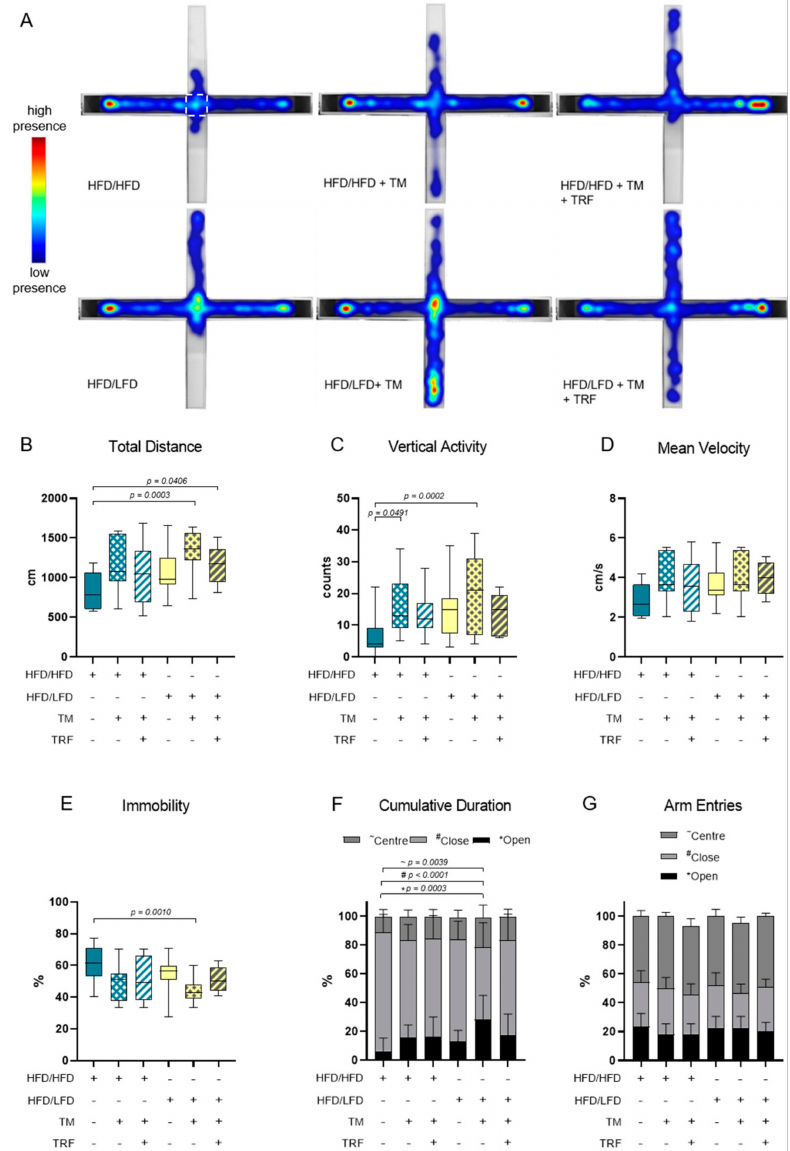
Figure 5. Elevated Plus Maze (EPM) analysis. The combination of a diet change and treadmill exercise leads to less anxiety-related behaviour. ( A ) Heatmap presentation of animal presence in the maze over 300 s whereas red colour reveals the highest residence and blue colour the lowest duration. The number of mice which exhibited the shown pattern amounted to: HFD/HFD: n = 7/13, HFD/HFD + TM: n = 5/13, HFD/HFD + TM + TRF: n = 7/15, HFD/LFD: n = 7/13, HFD/LFD + TM: n = 12/15, HFD/LFD + TM + TRF: n = 8/13, total n = 82. White dashed line indicates the centre. Boxplots indicate ( B ) total distance [cm] moved over 300 s, ( C ) vertical activity [counts] by manual counting of rearing, leanings and jumps, ( D ) mean velocity [cm/s] calculated from distance moved in maze over 300 s and ( E ) immobility pattern represented in [%]. ( F , G ) Column bars show cumulative duration [%] and arm entries [%] in centre (dark grey ~), in closed arm (light grey #) or in open arm (black *), respectively. Significance of differences were tested by Kruskal–Wallis with Dunn’s post hoc test for multiple comparisons (F, G~) or by ordinary one-way ANOVA with Tukey’s post hoc test for multiple comparisons (B: F = 2.043, DF = 5; C: F = 4.504, DF = 5; D: F = 2.149, DF = 5, E: F = 3931, DF = 5; G*: F = 2.043, DF = 5; G#: F = 2.006, DF = 5). Data are presented as mean ± SD and statistical significance was set at p < 0.05. Abbreviations: HFD: high-fat diet, LFD: low-fat diet, TM: treadmill, TRF: time-restricted